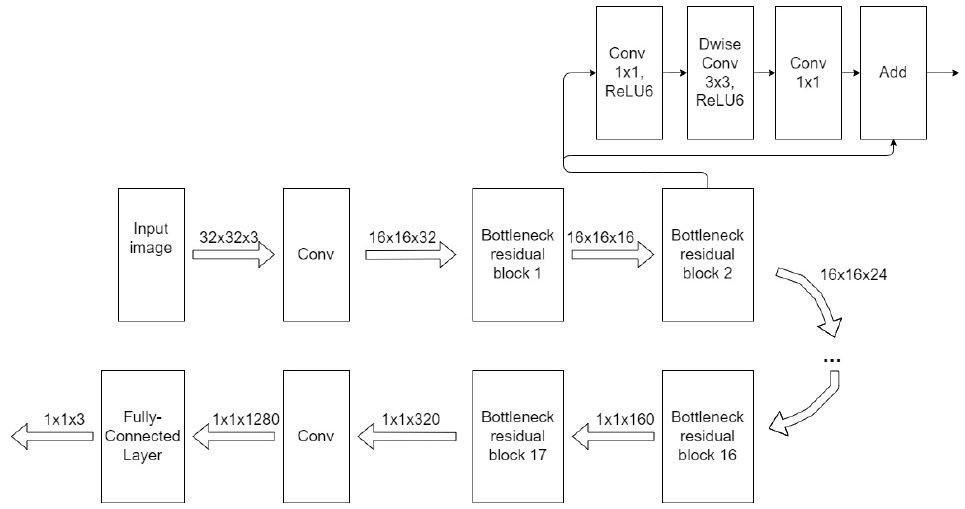
Figure 5. MobileNetV2 architecture.